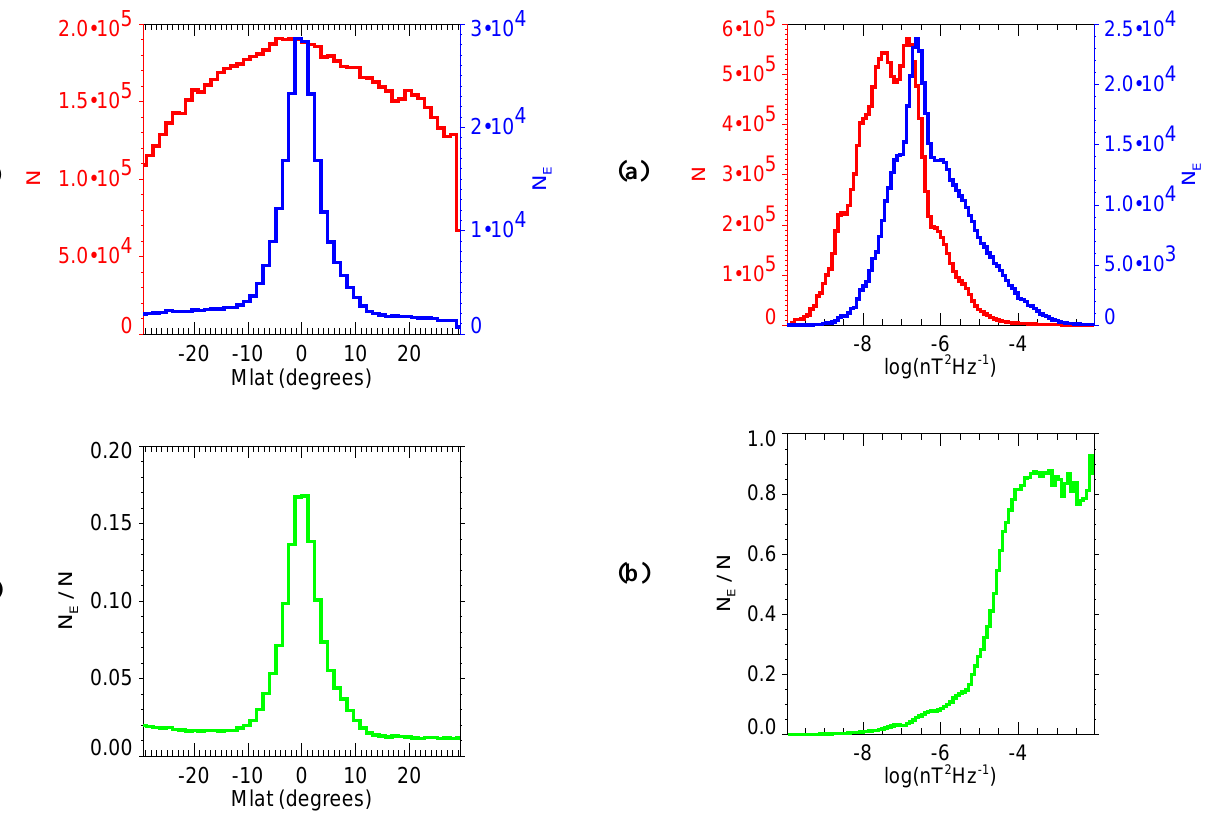
Fig. 4. The same as in Fig. 3, but for the magnetic dipole latitude. Fig. 5. The same as in Fig. 3, but for the sum of the power-spectral densities of the three components of magnetic field